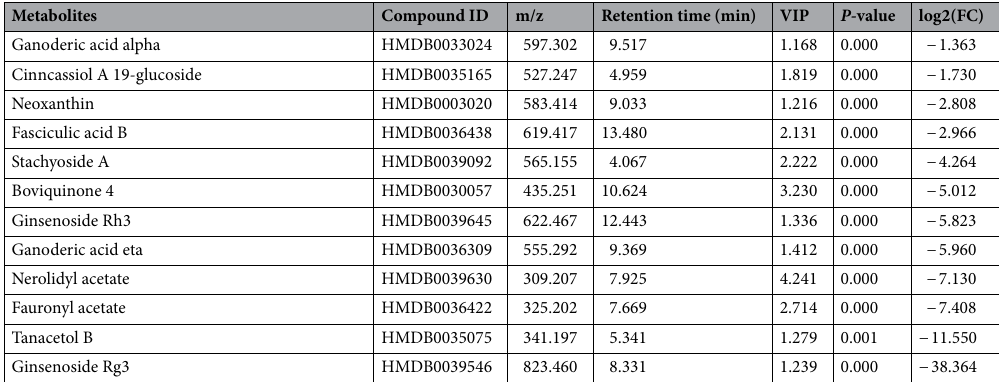
Table 2. Information of prenol lipids with significant